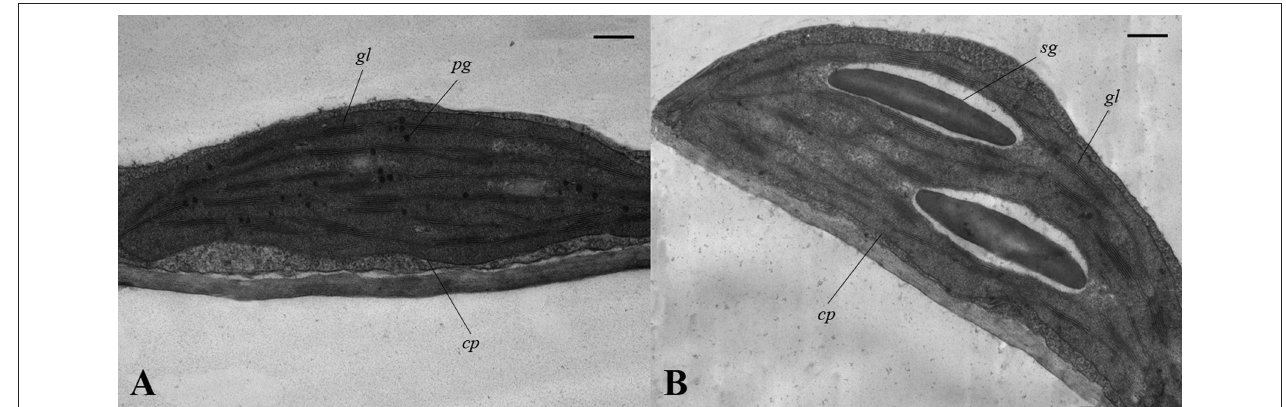
FIGURE 4 | Chloroplast ultrastructure of drm and wild-type “FT” at the seedling stage ( × 30,000). (A) chloroplasts of “FT;” (B) chloroplasts of drm ; cp chloroplast, sg starch grain, pg plastoglobule, gl grana lamella. Scale bar, 1 µ m.